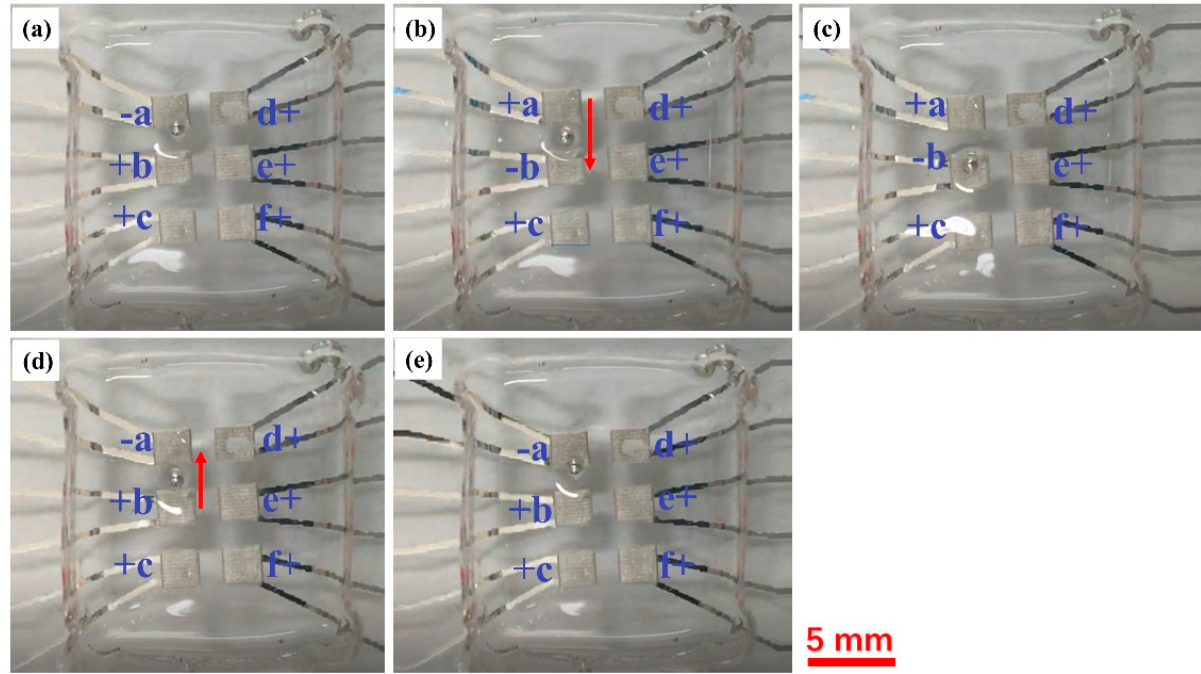
Figure 3. Experimental results for small LM droplet driving. Six electrodes are numbered as a–f. “+” represents +1000 V, and “ − ” represents − 1000 V. The small droplet is controlled to travel between electrodes “a” and “b”. ( a ) Droplet initial position at electrode “a”; ( b ) droplet traveling towards electrode “b”; ( c ) stabilized position of droplet at electrode “b”; ( d ) droplet traveling back to electrode “a”; ( e ) stabilized position of droplet at electrode “a”.